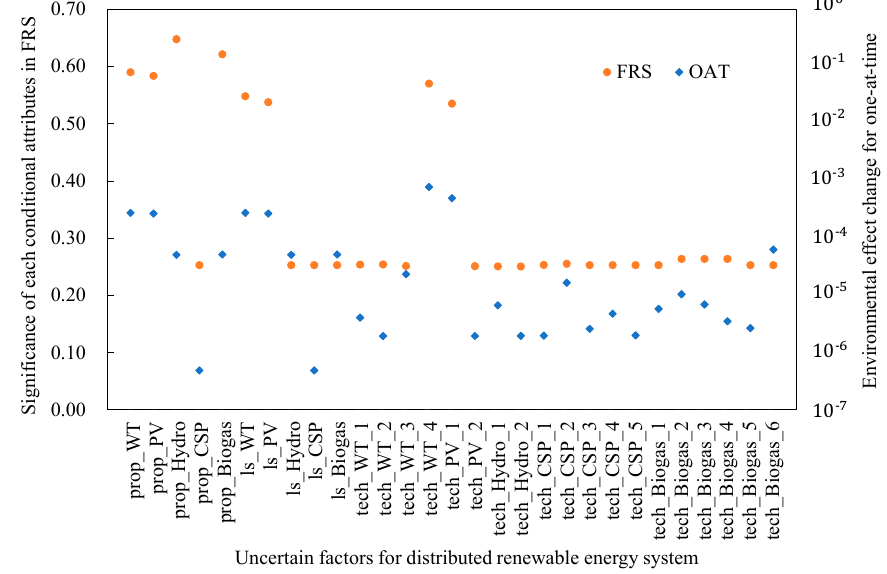
Figure 5. Identifying crucial uncertain factors for distributed renewable energy system (DRES) through fuzzy rough sets (FRS) and one-at-a-time (OAT) approaches.